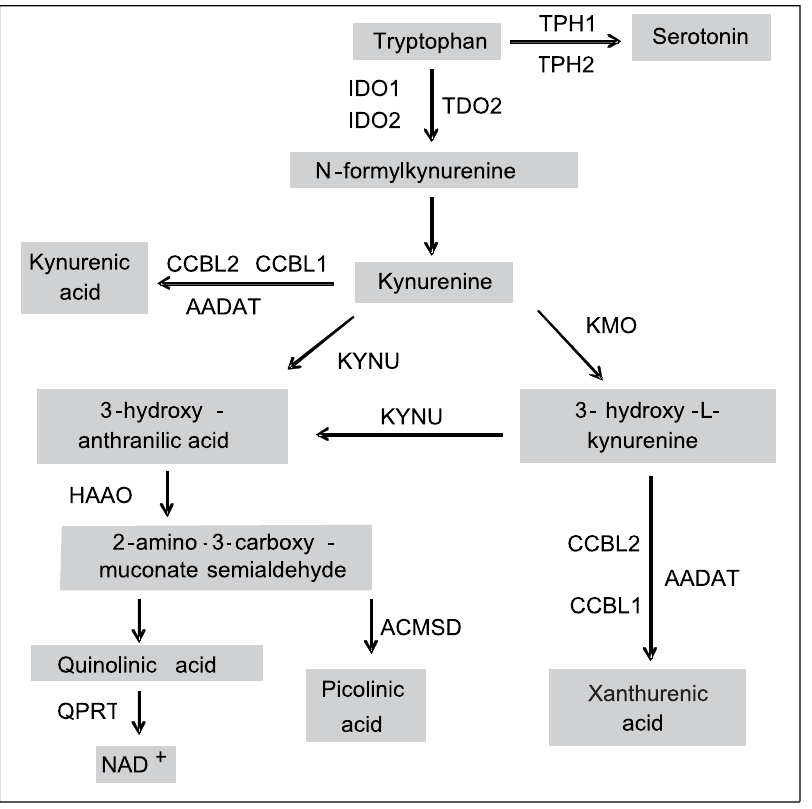
Fig 1. Schematic representation of the kynurenine pathway. IDO1, indoleamine 2,3-dioxygenase 1; IDO2, indoleamine 2,3-dioxygenase 2; TDO2, tryptophan 2,3-dioxygenase; TPH1, Tryptophan hydroxylase 1; TPH2, Tryptophan hydroxylase 2; AFMID, arylformamidase; KMO, kynurenine 3-monooxygenase; CCBL1, kynurenine aminotransferase I; AADAT, kynurenine aminotransferase II; CCBL2, kynurenine aminotransferase III; KYNU, kynureninase; HAAO, 3-hydroxyanthranilate 3,4-dioxygenase; QPRT, quinolinate phosphoribosyl transferase; ACMSD, aminocarboxymuconate semialdehyde decarboxylase.